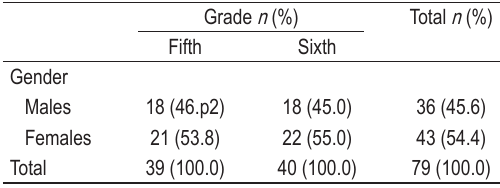
TABLE 1. Gender distribution in fifth‑ and sixth‑grade